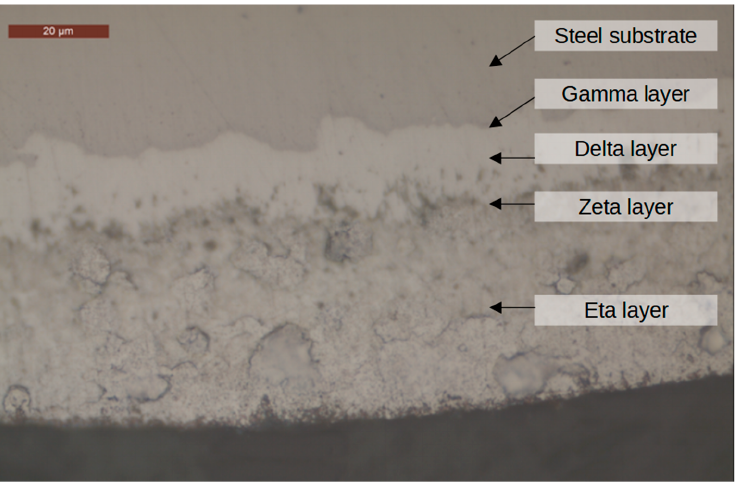
Figure 5. Intermetallic layers in the steel substrate.